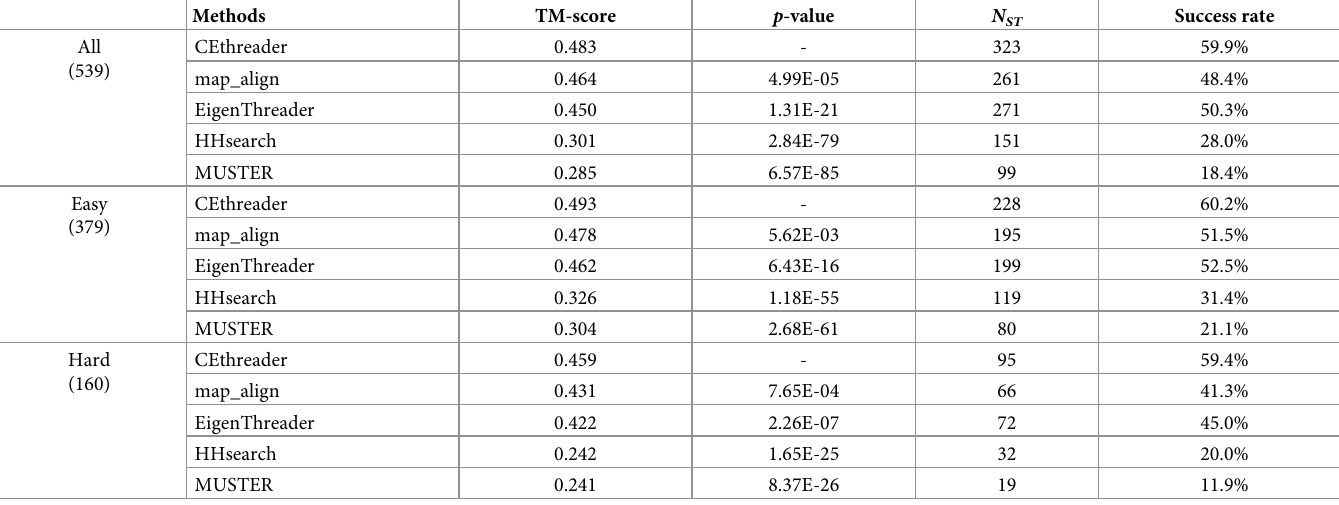
Table 2. Threading results obtained by different methods for the 539 proteins from Benchmark Set-II. P -values were calculated between the CEthreader alignment TM-scores and other methods’ TM-scores using one-sided Wilcoxon signed-rank tests; N ST represents the number of targets with a first identified template whose TM- score was > 0.5; the success rate is equal to the fraction of targets whose Folds were correctly recognized, i.e., the first identified template had the same Fold as the